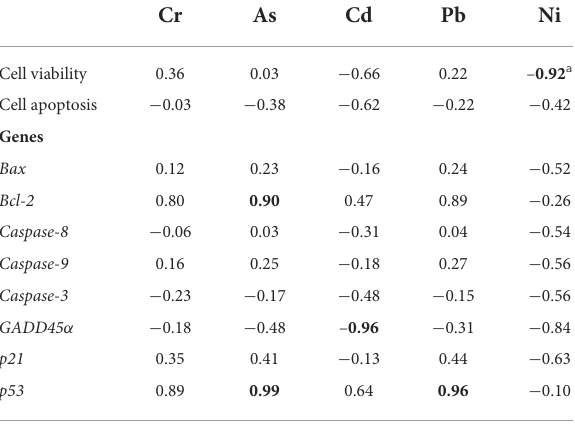
TABLE 3 Pearson correlation coefficients between wild vegetable bioaccessible metal(loid)s and various toxicity indexes (cell viability, apoptosis, and genes) in HGEC after exposures to four extracts for